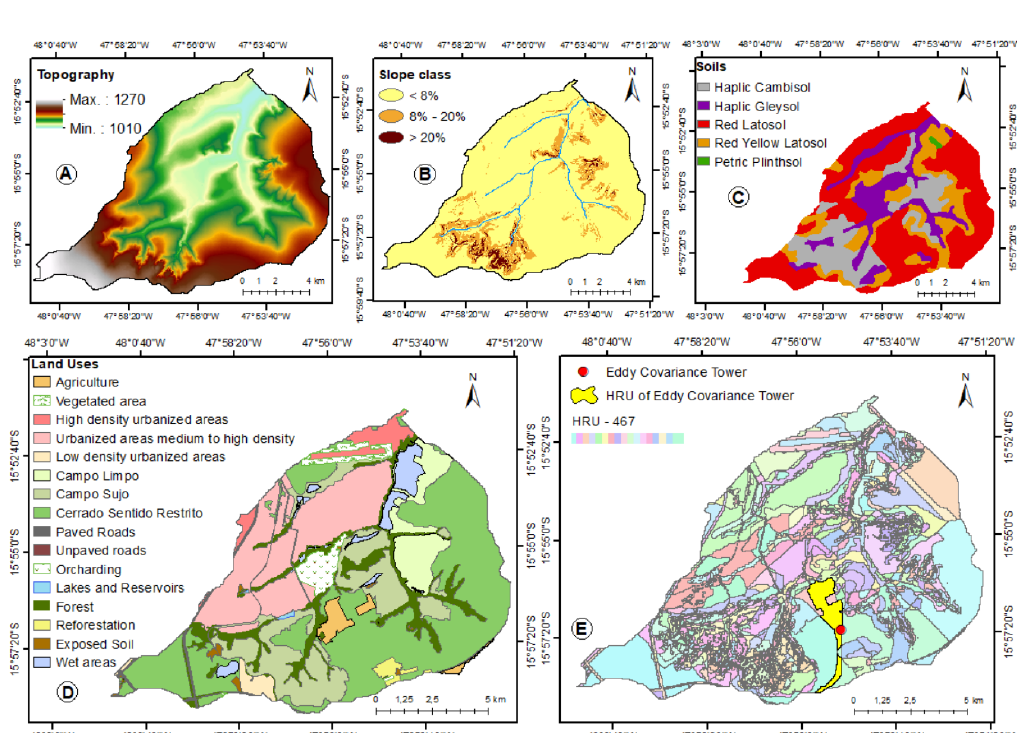
Figure 2. ( A ) Digital Elevation Model (DEM); ( B ) slope classes; ( C ) pedology; ( D ) land use and land cover in the Ribeirão do Gama Basin; ( E ) HRUs obtained for the study area, with emphasis on the HRU where the EC tower is located.